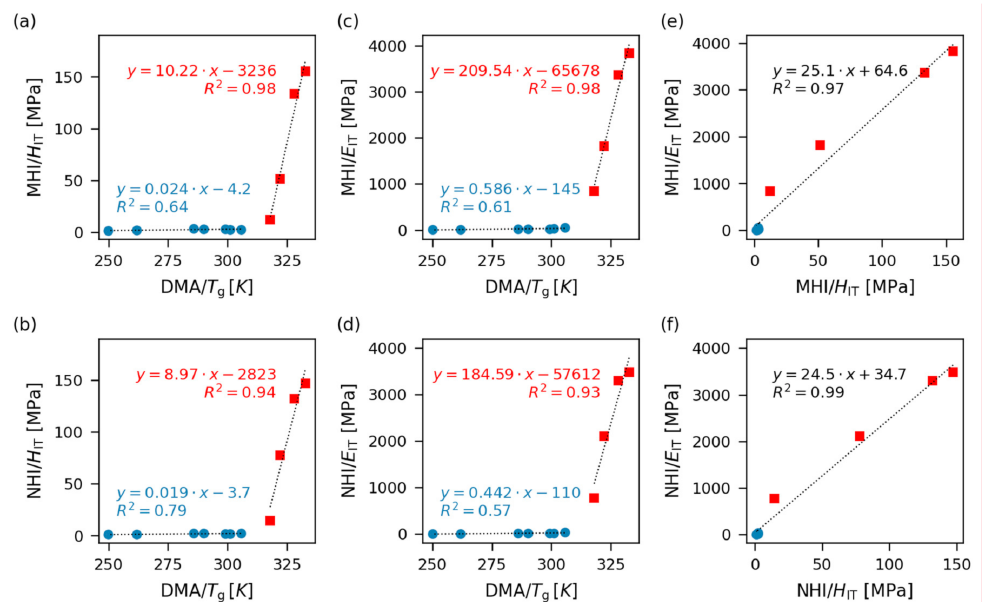
Figure 8. Correlations among glass transition temperature from DMA (DMA / T g ), indentation hardness from micro- and nanoindentation (MHI / H IT ( a ) and NHI / H IT ( b )), and indentation modulus from micro- and nanoindentation (MHI / E IT ( c ) and NHI / E IT ( d )). Subfigures ( e ) and ( f ) show correlations between indentation hardness and indentation modulus from micro- and nanoindentation,